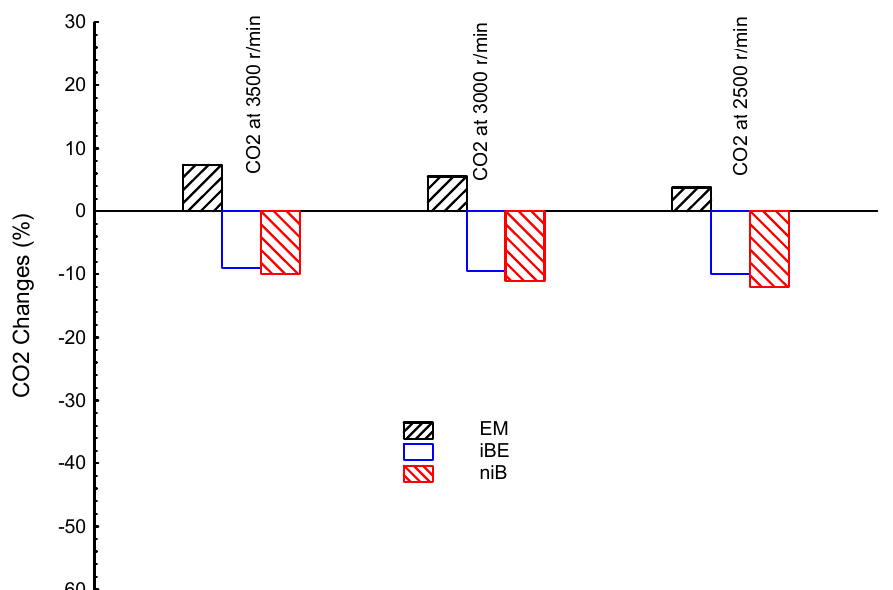
Figure 7. UHC emission at three di ff erent engine speeds (3500, 3000, and 2500 r/min) for ternary blended fuels of bio-ethanol–bio-methanol–gasoline (EM), iso-butanol–bio-ethanol–gasoline (iBE), and n-butanol–iso-butanol–gasoline (niB); gasoline is the reference line. Figure 8 shows CO 2 emissions for the ternary blended fuels (EM, iBE, and niB) and gasoline as the reference line at three di ff erent engine speeds (3500, 3000, and 2500 r/min). As shown, the most CO 2 is introduced by EM at all speeds, where the emission levels are higher than the G fuel; while both iBE and niB showed lower CO 2 levels than the G fuel. The lowest CO 2 is introduced by niB among all ternary blends at all engine speeds, as shown in Figure 8. The CO 2 emissions for di ff erent blends are reproduced as averages for an easier comparison point of view, as presented subsequently.